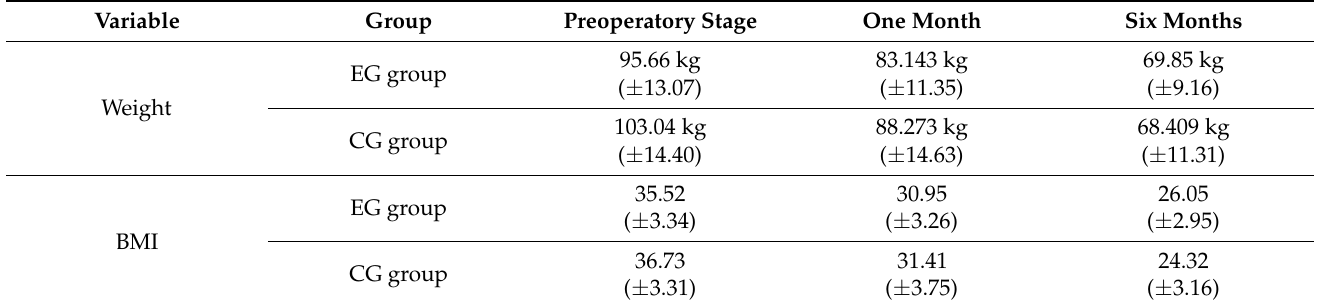
Table 2. Weight and BMI of participants.